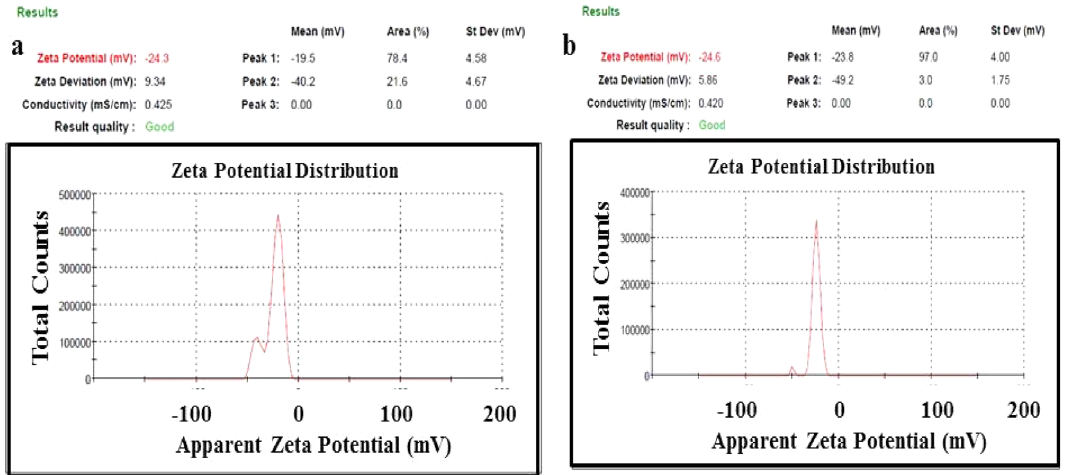
Figure 4. Zeta potential of biochar ( a ) and Ag/ZnO@BC composite ( b